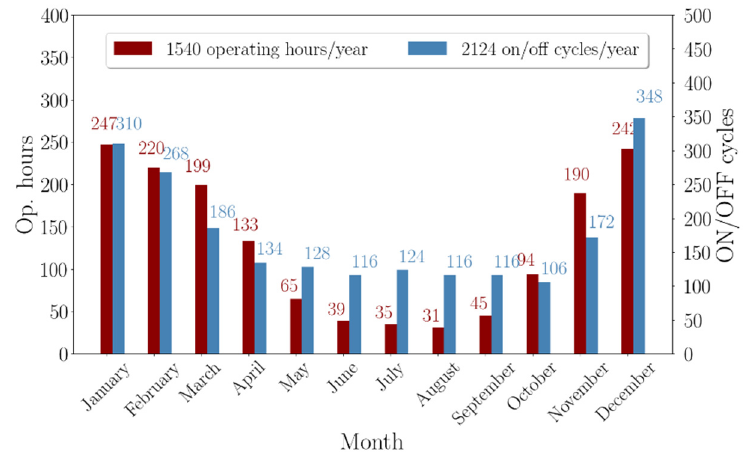
Figure 14. Monthly number of operating hours and on/off cycles for the heat pump.